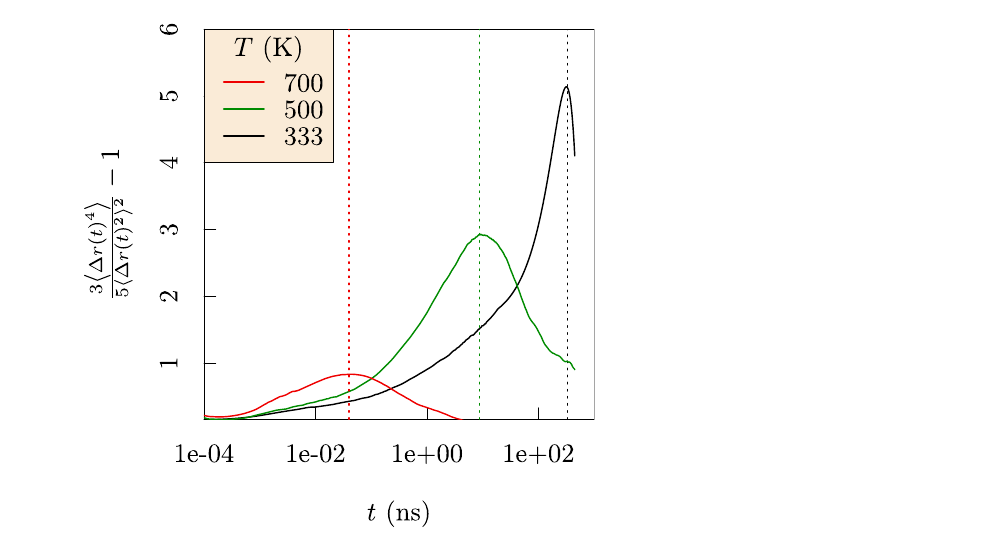
Figure 4. Dimensionally-scaled G s ( r , t ) for Li + ions as it depends on displacement for increasing times in EDC (left) and EC (right). Though the Gaussian model (dashed curve) is reliable in EC solvent, probability is 1/2 > ∆ depleted near the trap boundaries, r r t ( ) 2 , and replaced at shorter and longer distances for EDC. Note that these correlations decay in a few ps for EC, but require ns for EDC. (Redrawn with permission from ECS Transactions 77, 1155–1162 (2017)) 13 .